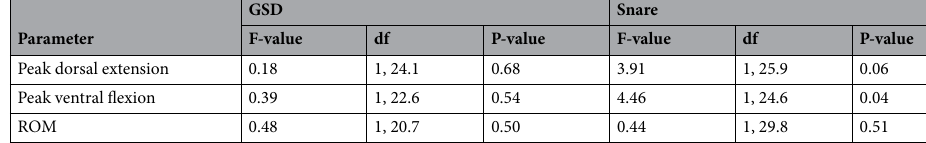
Table 6. Effects of GSD and snare injuries on neck angle limb kinematics in free-ranging Nubian giraffe Giraffa camelopardalis camelopardalis from Murchison Falls National Park, Uganda.